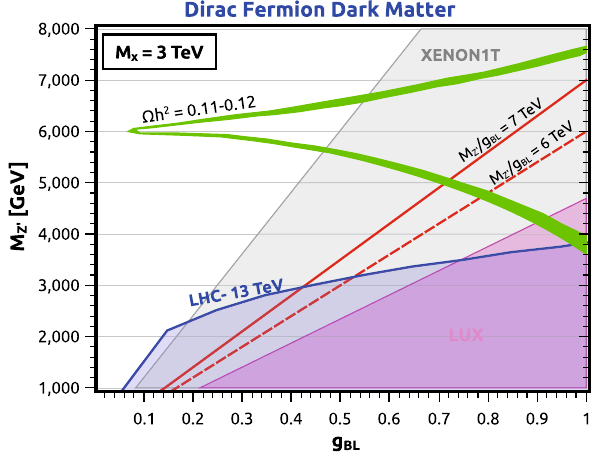
Fig. 11 Allowed region of parameters for a 3 TeV Dirac fermion as darkmatter.The greencurve delimitstheregionofparameterspacewith therightabundance( (cid:2) h 2 = 0 . 11 − 0 . 12),the pink ( gray ) shadedregion is ruled out by LUX2016 (XENON1T), the blue region is excluded by dilepton data from the LHC, and the solid red ( dashed ) lines rep- resent the current (old) LEP-II bounds, namely M Z (cid:2) / g BL > 7 TeV ( M Z (cid:2) / g BL > 6